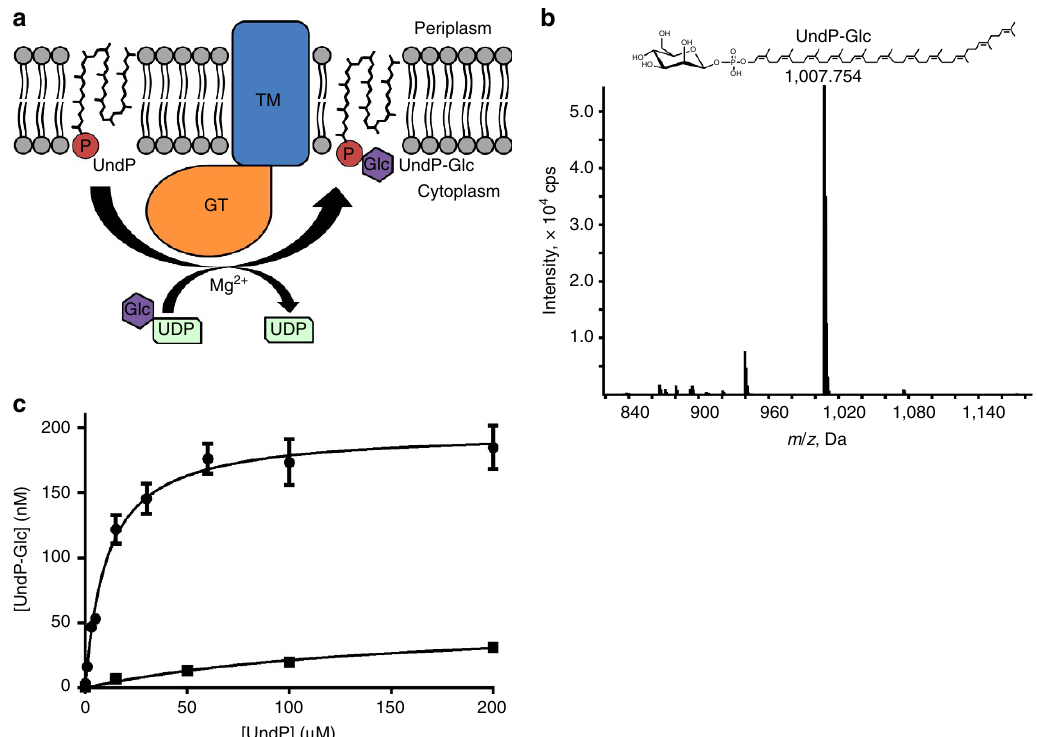
Figure 1 | GtrB catalyses the formation of UndP-glucose in vivo and in vitro . ( a ) GtrB (TM domain in blue, GT domain in orange) catalyses the transfer of a glucose from UDP-glucose to UndP, producing UndP-glucose. ( b ) Cells overexpressing GtrB accumulate a species detected by negative ion ESI/MS at m / z of 1,007.75, corresponding to the [M-H]-ion of UndP-glucose. Its identity was further confirmed by tandem mass spectrometry (MS/MS). ( c ) When incubated with varying concentrations of UndP for 1h, membranes prepared from GtrB-overexpressing cells accumulate UndP-glucose (UndP-Glc) in a concentration-dependent manner (circles), whereas those prepared from control cells overexpressing a membrane protein of unrelated function do not (squares). Error bars are provided as ± s.e.m., n ¼